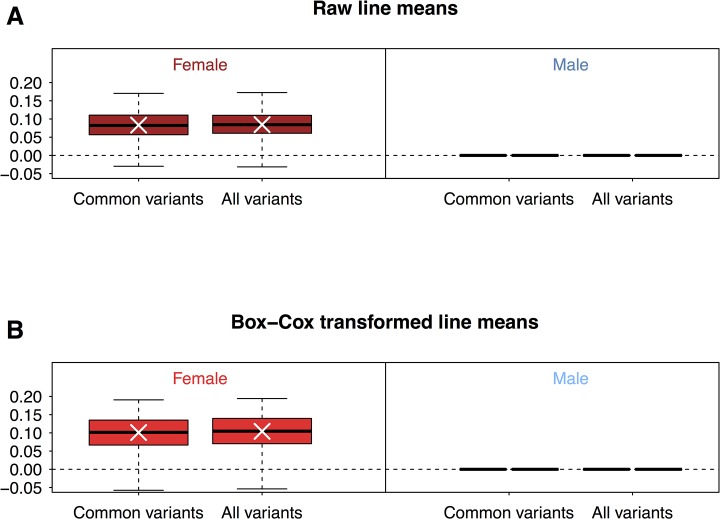
Prediction accuracy using common or all variants with raw line means or Box-Cox transformed line means.Prediction accuracy of GBLUP for 100 replicates of 5-fold cross-validation (CV) are plotted as box plots, for females and males separately. We performed the analysis using either raw line means (A) or line means transformed by Box-Cox transformation (B).